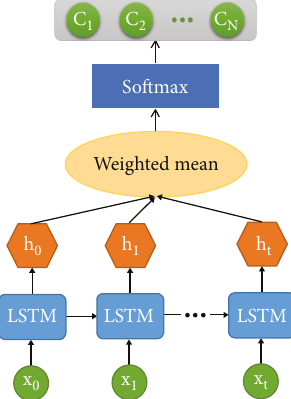
Figure 7: The structure of the proposed